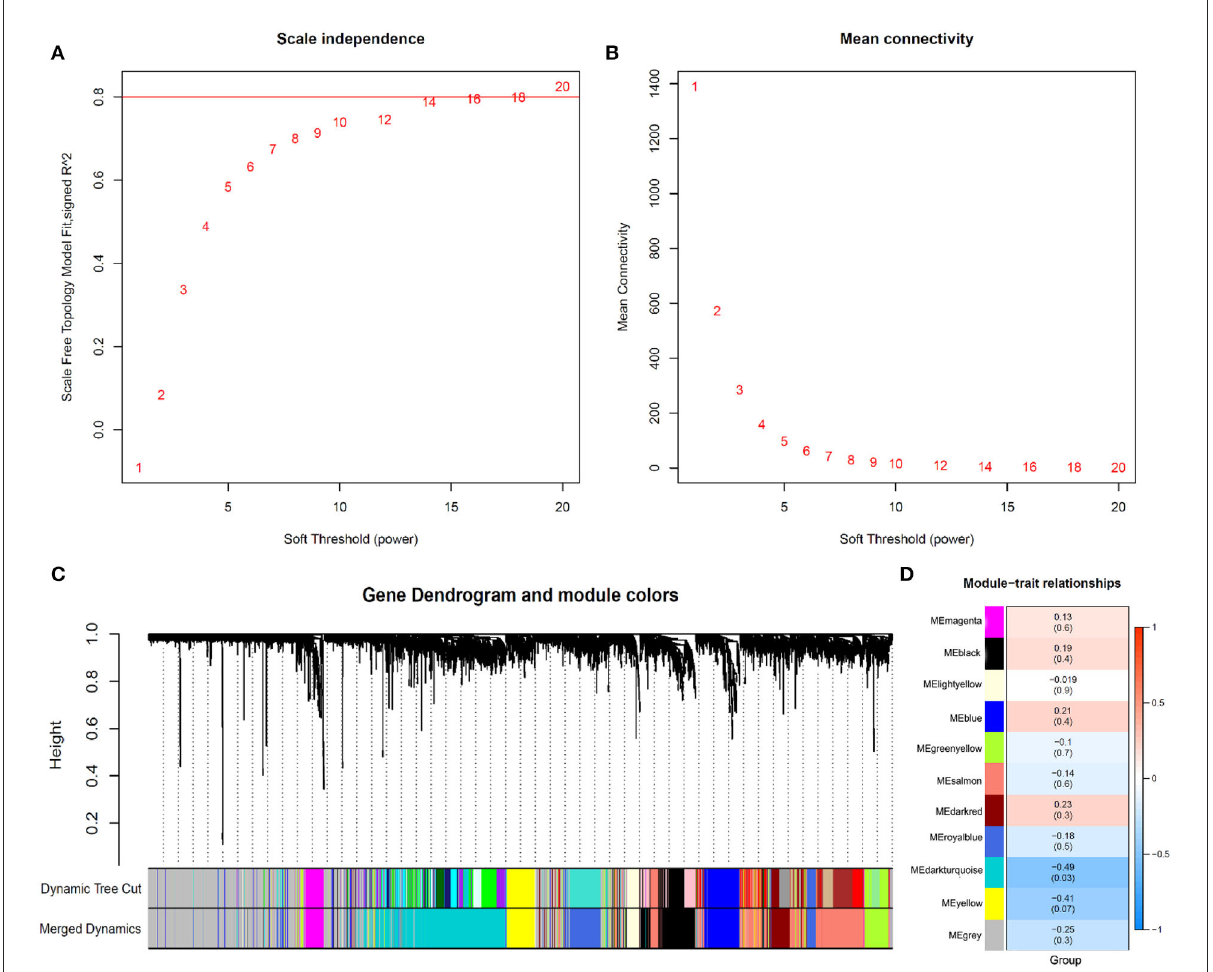
FIGURE2 Identification of modules associated with the clinical subtypes of AUVP. (A) Analysis of the scale-free fit index for different soft-thresholding power. (B) Analysis of the mean connectivity for different soft-thresholding power. (C) Dendrogram of all differentially expressed genes clustered. (D) Heatmap of the correlation between gene modules and clinical information of